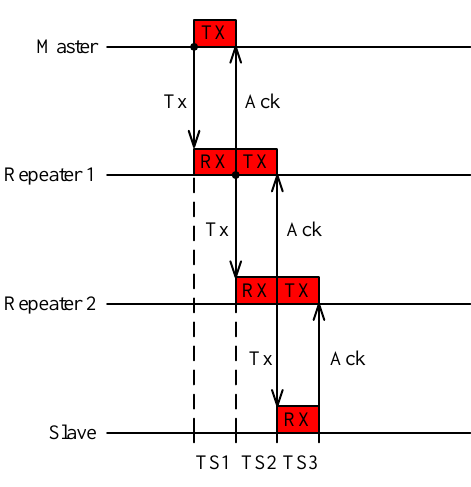
Figure 2. Impact of time division multiplex for PLC and Broadband over Power Lines (BPL) repeaters.